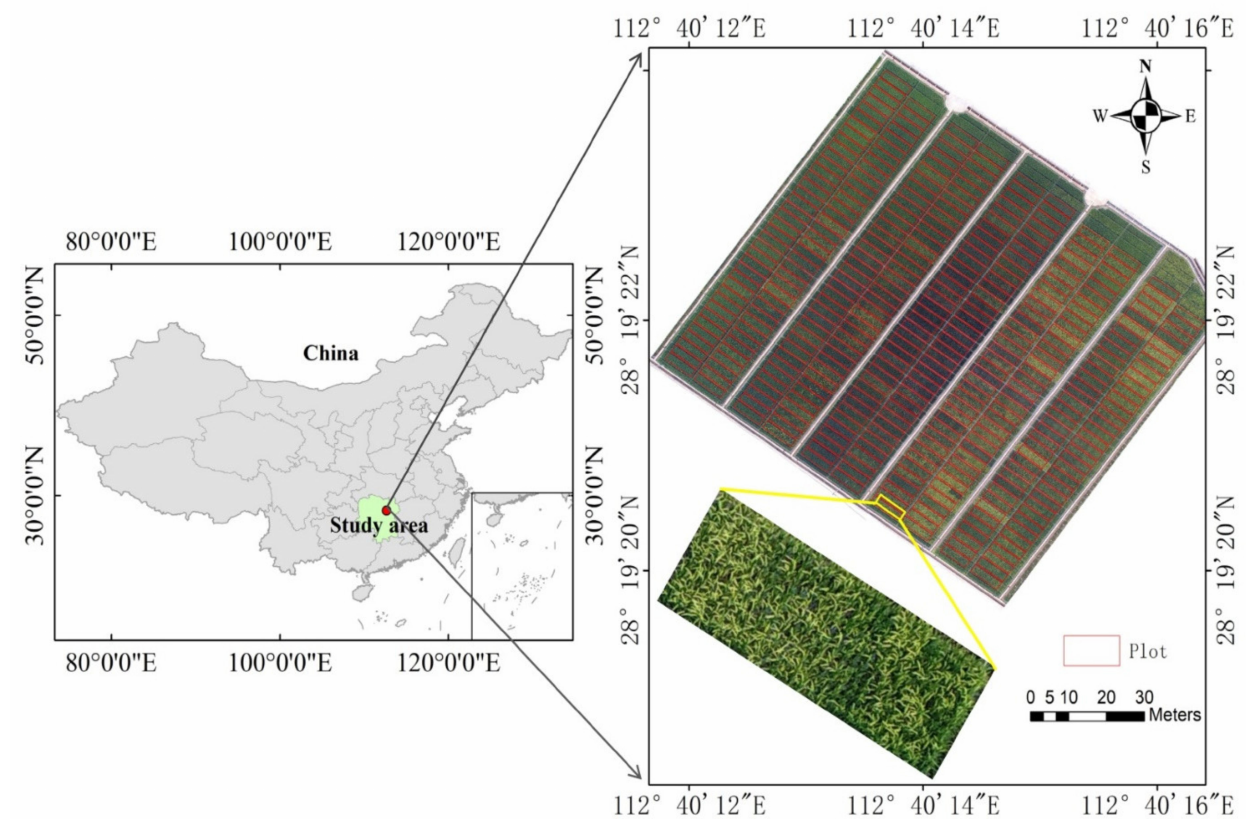
Figure 1. Study area with the aerial image of the experimental